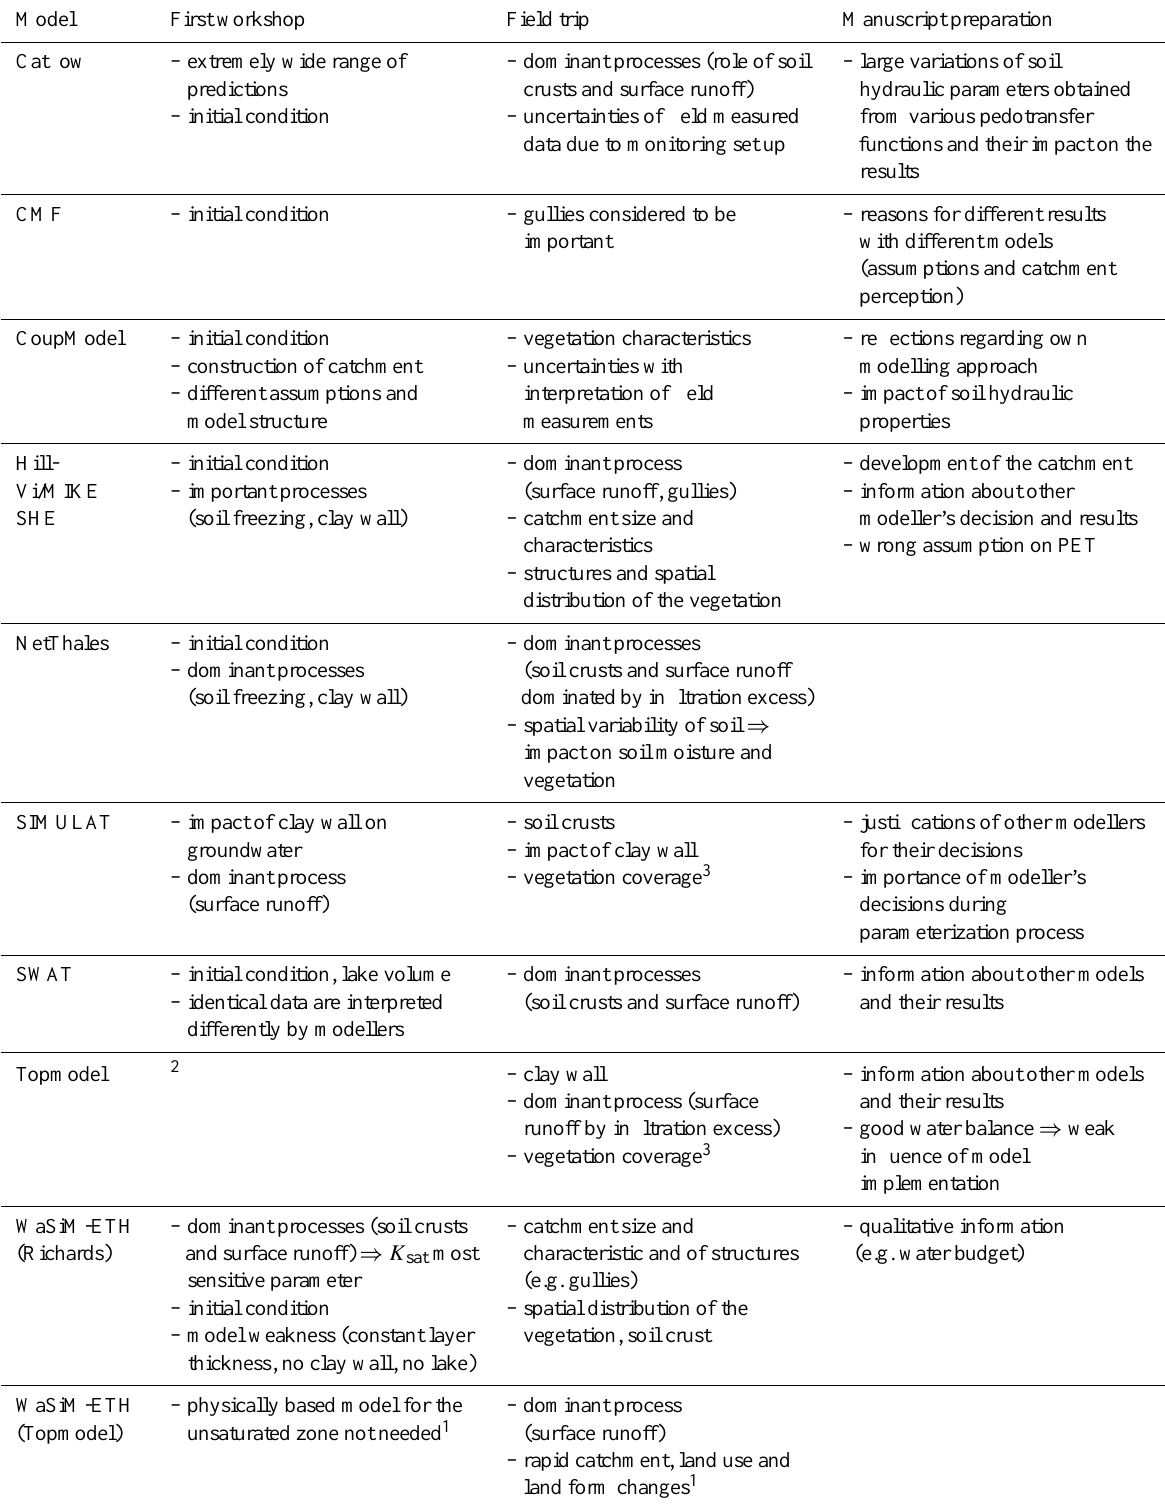
Table 2. Process understanding gained and lessons learnt during the three steps of the project